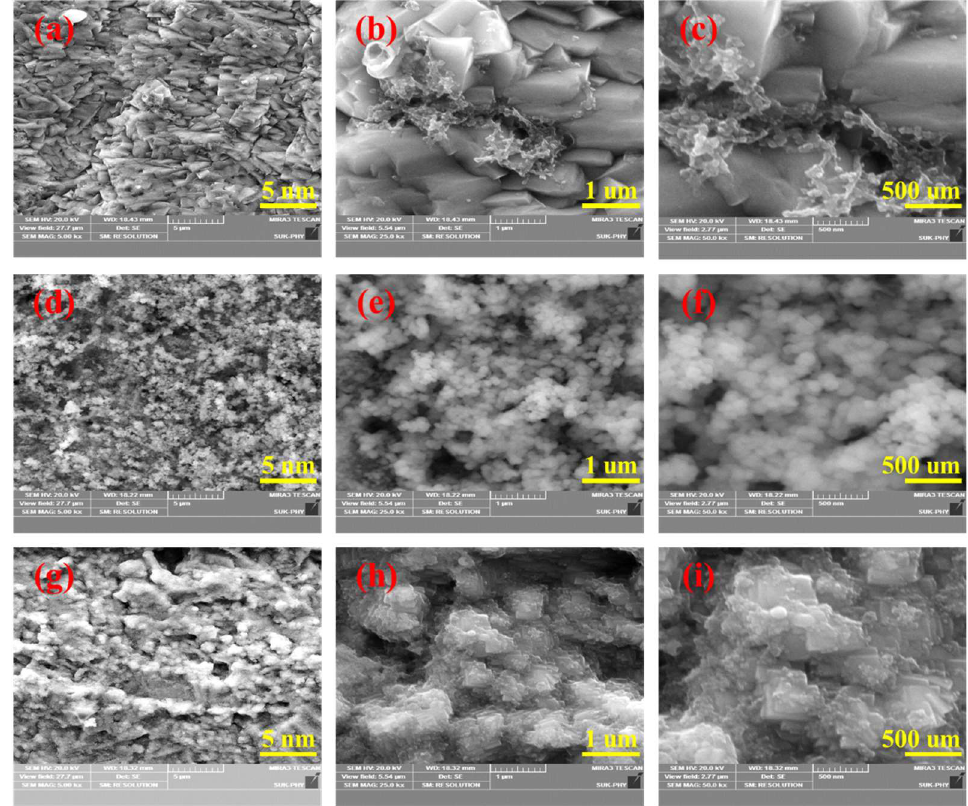
Figure 2. ( a – c ) SEM images of S1, ( d – f ) S2, and ( g – i ) S3 thin films at different magnifications.